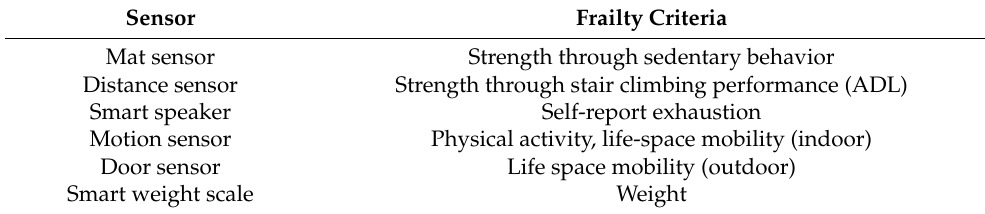
Table 1. Sensors’ hardware components, corresponding frailty